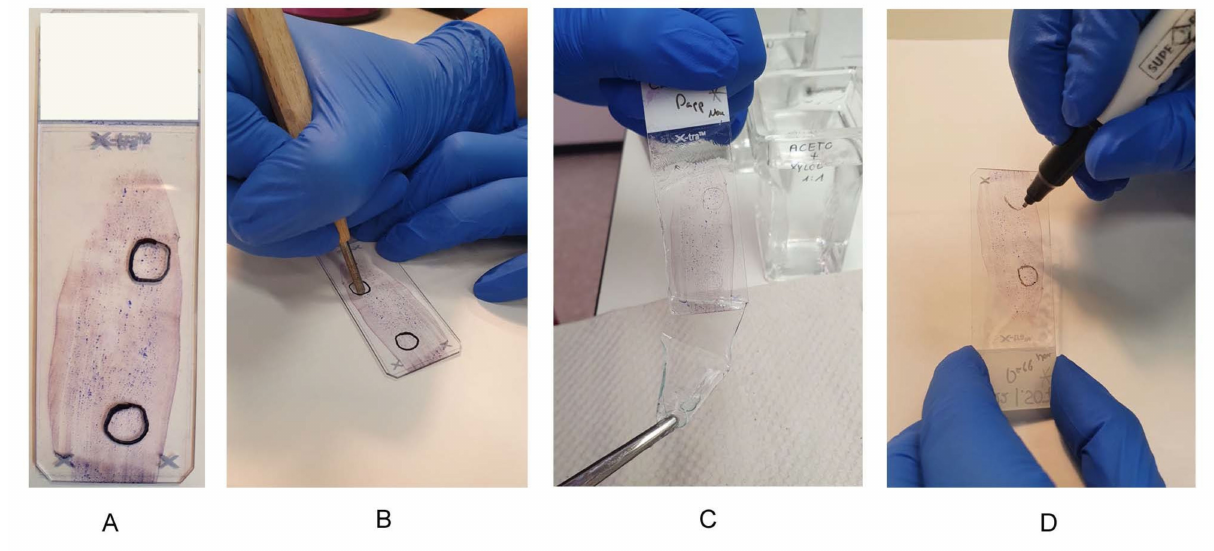
Figure 2. Preanalytical steps on cytological preparations. Preanalytical steps on cytological prepara- tions. ( A ) Suitable smear with two areas, one area for DNA extraction and one area for FISH analysis; ( B ) use of a diamond stylus, scratching the marking on the back of a slide; ( C ) uncovering the slide in xylene; ( D ) trace the diamond scratches with a waterproof